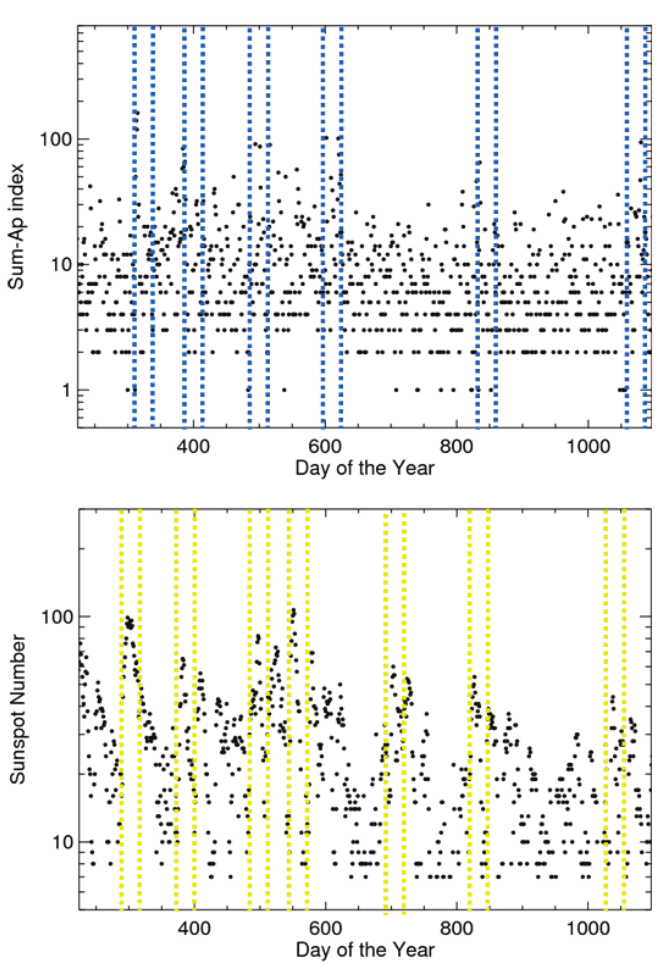
Figure 1. Daily Ap-index (upper panel) and sunspot number (lower panel) variations versus DOY (first day: January 1, 2004). The period investigated starts from August 8, 2004 (DOY 221) and goes to December 31, 2006 (DOY 1098). The blue and yellow vertical lines indicate the periods of high geomagnetic and solar